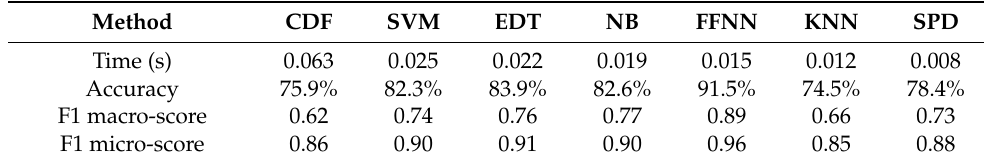
Table 5. Classification performance of the tested methods.